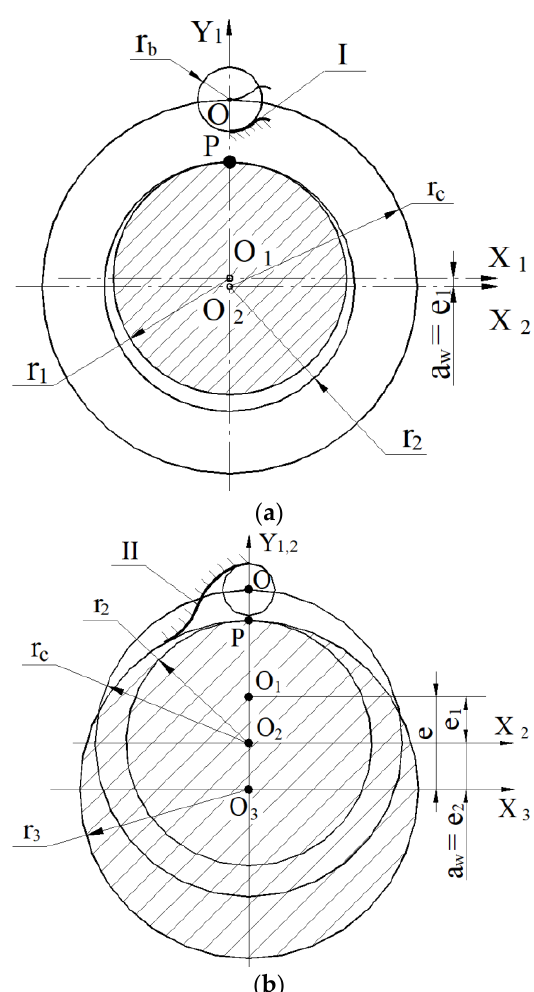
Figure 2. Toothing of the transmission with intermediate rolling elements and a free cage: ( a ) — rolling elements with a cam; ( b ) — rolling elements with a crown.